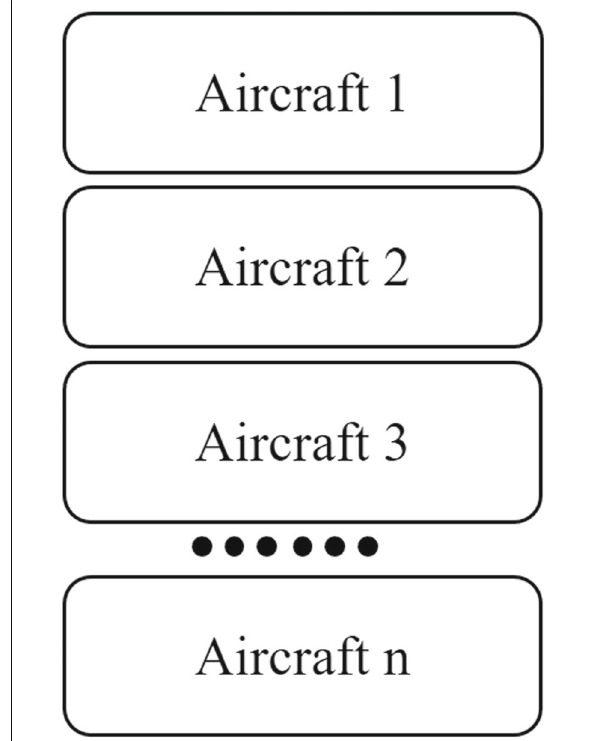
Fig. 4 Dataset arrangement according to different flights